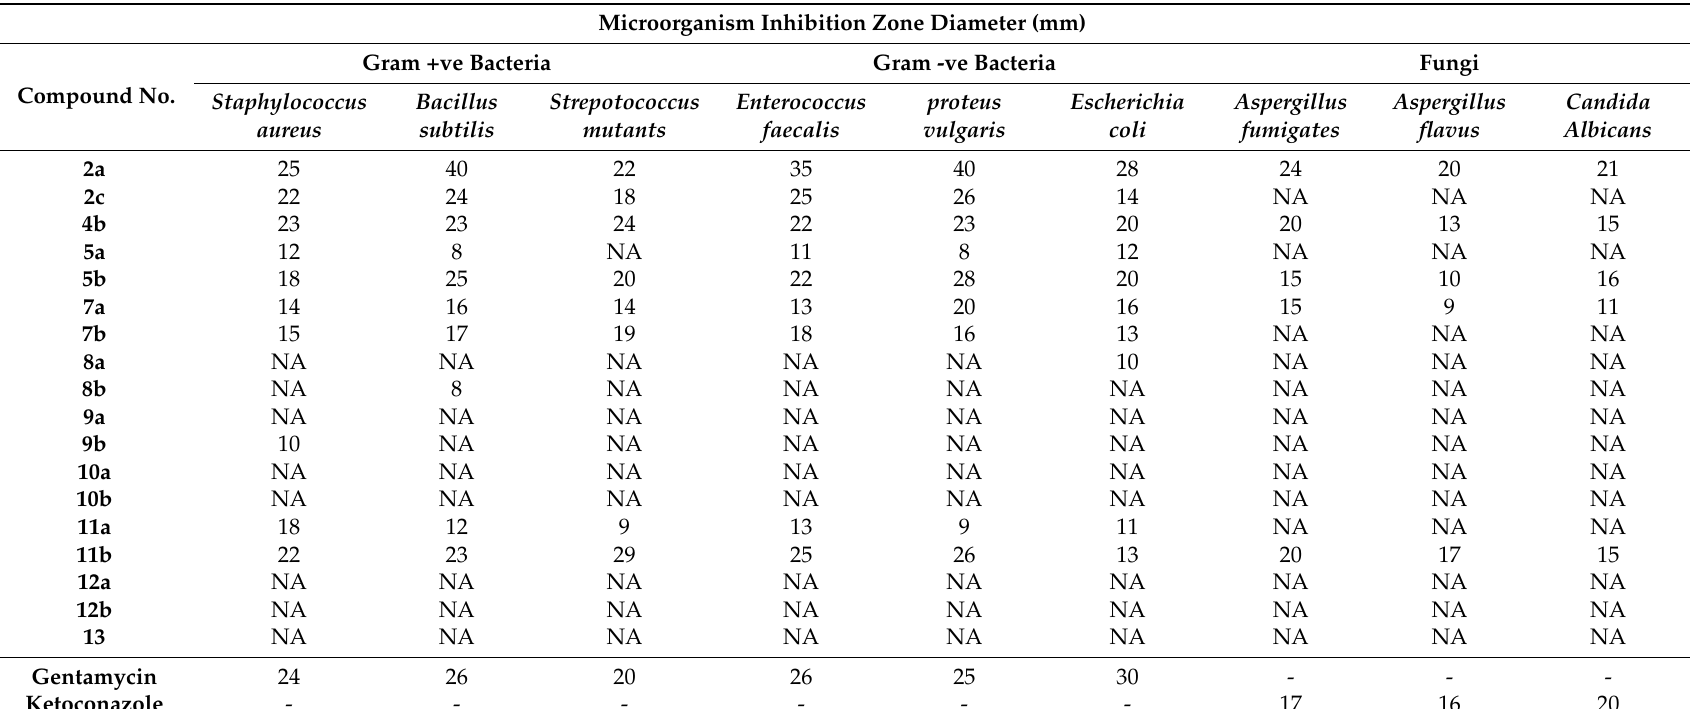
Table 3. Inhibition zone in (mm) as a criterion of antimicrobial activity of some newly synthesized compounds. Microorganism Inhibition Zone Diameter